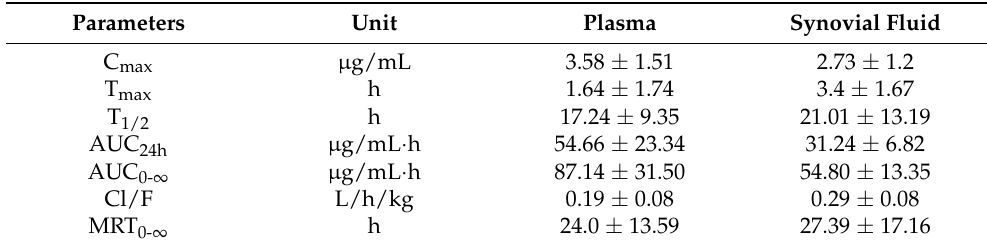
Figure 1. Semi-logarithmic graph illustrating the time-concentration curve of florfenicol in plasma and synovial samples of pigs after a single intramuscular administration of 15 mg/kg bw (n = 6). Table 2. Plasma and synovial fluid PK parameters (mean ± SD) of florfenicol in pigs following intramuscular administration of 15 mg/kgbw (n =